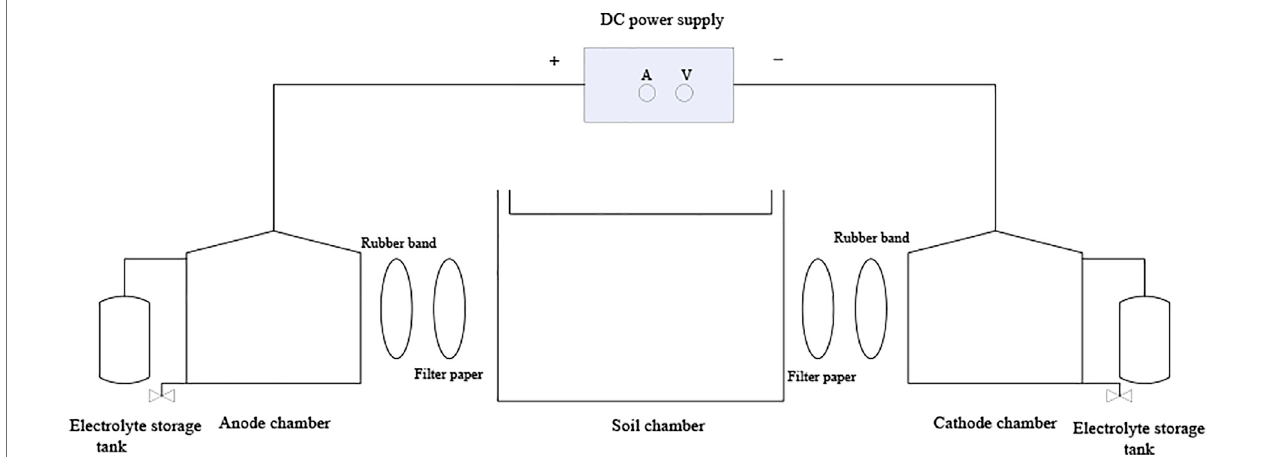
FIGURE 5 | Schematic diagram of the experimental